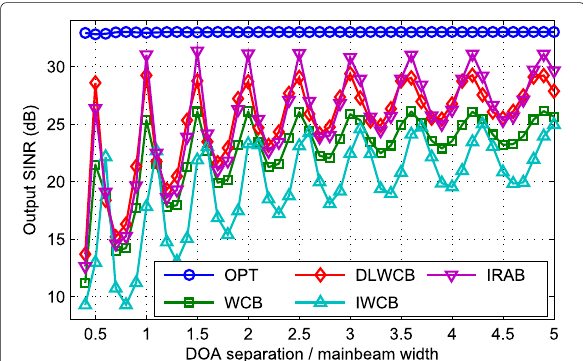
Fig. 11 SINR versus DOA separation: M=10, mainbeam width=24 ◦